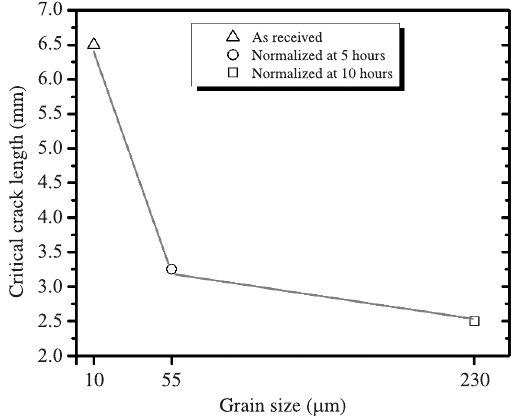
Figure 4. Plot of critical crack length as a function of grain size for the HAZ normalized at 1200 °C for different time